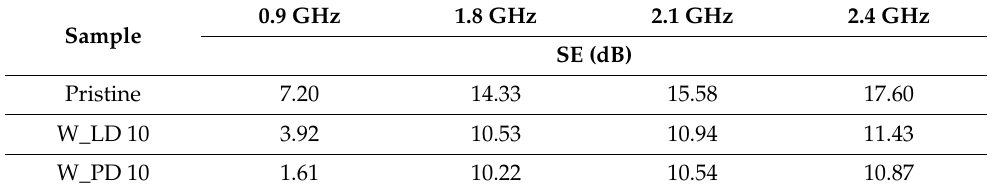
washing with liquid and powder detergent at frequencies 0.9 GHz, 1.8 GHz, 2.1 GHz, and 2.4 GHz.